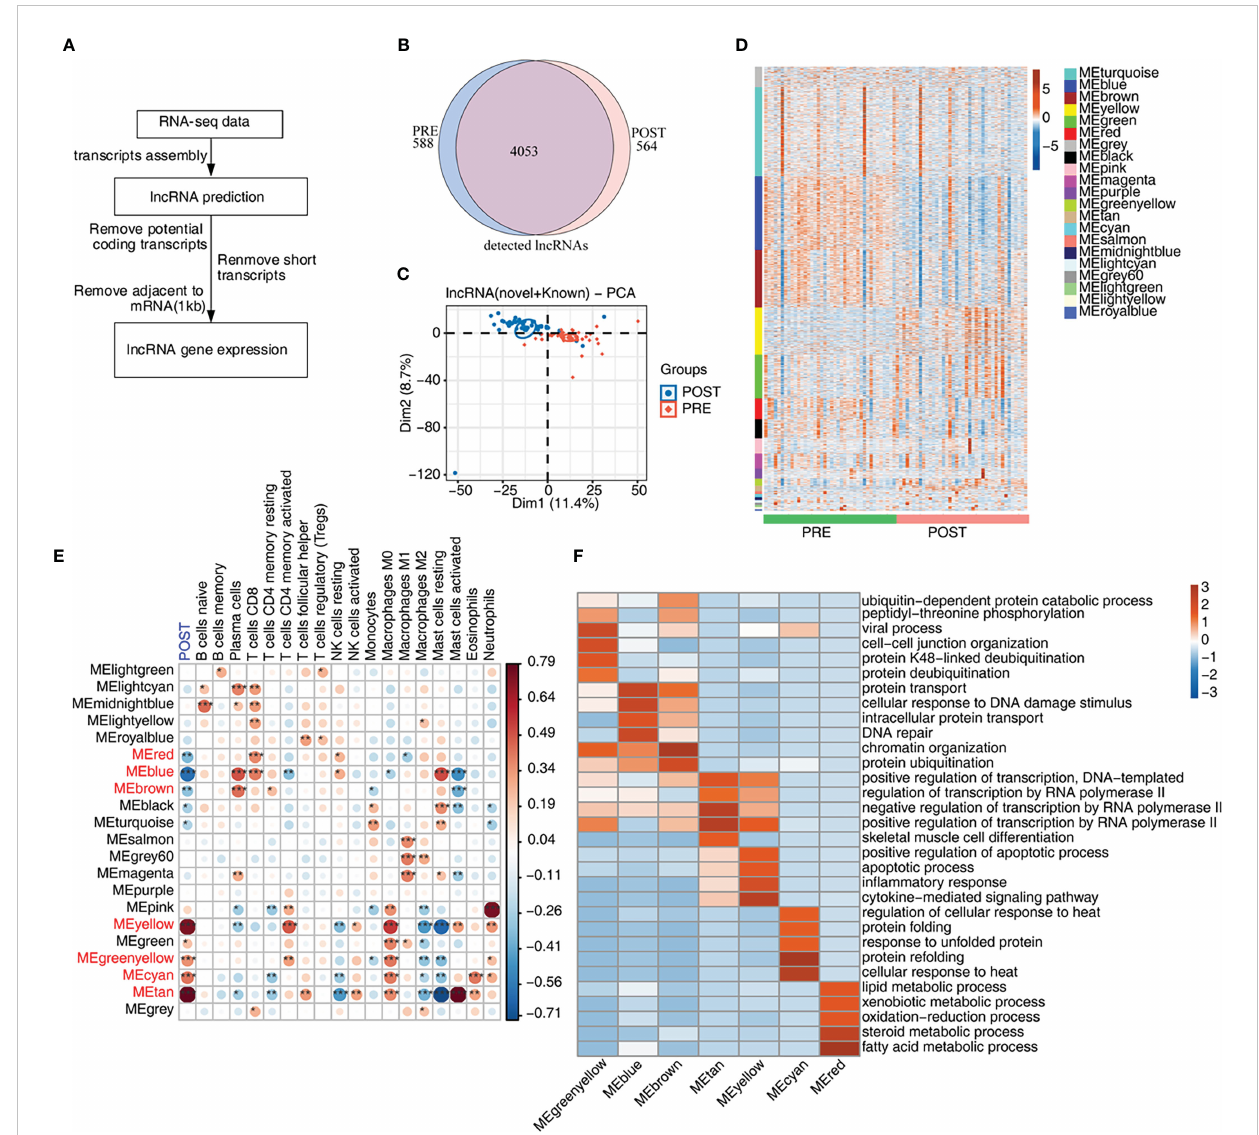
FIGURE 2 Genome-wide pro fi ling of the immune-associated lncRNA expression before and after LT. (A) Figure 2A presents bioinformatics analysis pipeline for the identi fi cation of lncRNAs. (B) Venn diagram shows the number of detected lncRNAs. The known and newly predicted lncRNAs are overlapped, and more than 1 samples with FPKM < = 0.2 were supposed to be detected. (C) PCA based on FPKM values of all detected genes. The ellipse for each group is the con fi dence ellipse. (D) WGCNA analysis of all expressed mRNAs and lncRNAs is performed. Heat map displays lncRNA and mRNA expression levels according to WGCNA modules. (E) WGCNA module-trait associations are plotted using ‘ plotEigengeneNetworks ’ function with all factors (LT status and cell fractions) on the x-axis acting as covariates. Modules in red font were LT-associated modules. The colors indicate Pearson ’ s correlation values and p values are displayed with stars. * p -value < 0.05; ** p -value < 0.01; *** p -value < 0.001. (F) The heat map shows that the GO items (BPs) of 7 module traits with WGCNA p -value <